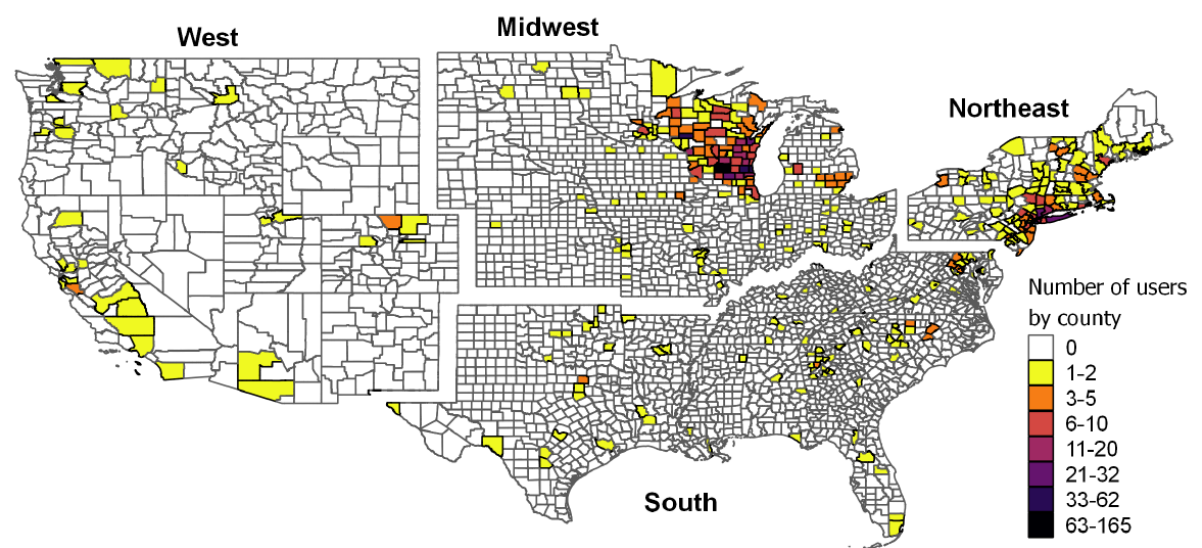
Figure 3. Number of users per county and per region for the United States by the major census regions in the United States.